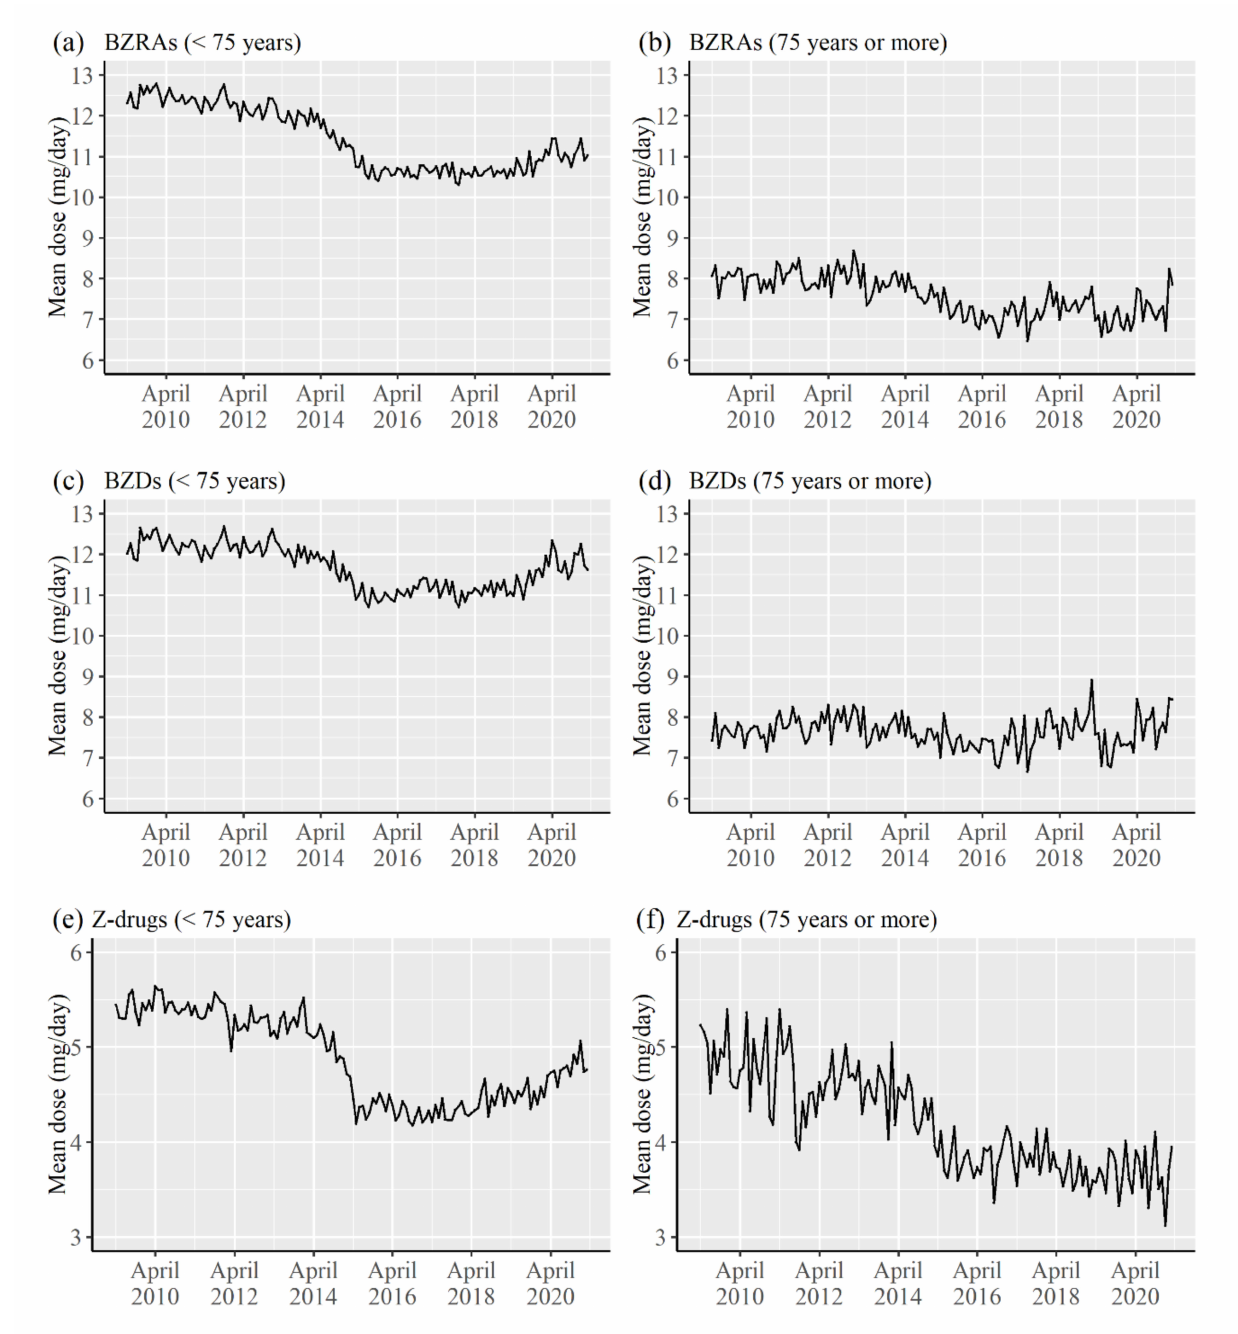
Figure 3. Trends of the mean of average daily doses (diazepam-equivalent mg/day) for a patient in a month by the age groups and the type of drug. ( a ) Mean for BZRAs in patients aged <75 years, ( b ) Mean for BZRAs among patients aged ≥ 75 years, ( c ) Mean for BZDs among patients aged <75 years, ( d ) Mean for BZDs among patients aged ≥ 75 years, ( e ) Mean for Z-drugs among patients aged <75 years, ( f ) Mean for BZDs among patients aged ≥ 75